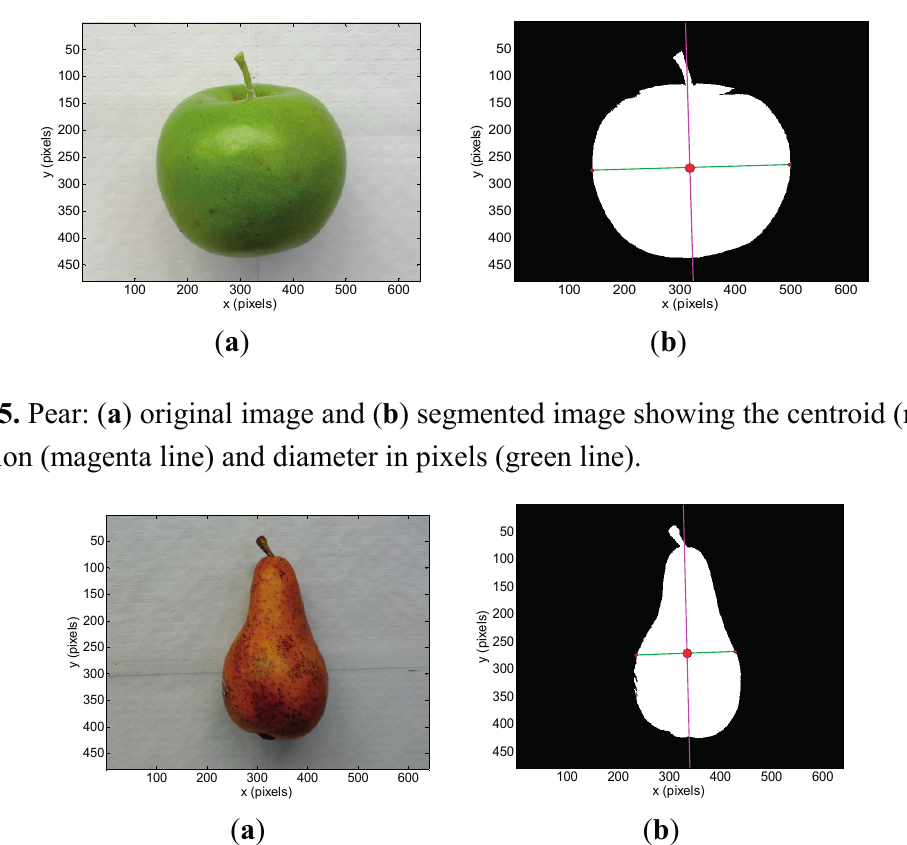
Figure 4. Apple: ( a ) original image and ( b ) segmented image showing the centroid (red dot), inclination (magenta line) and diameter in pixels (green line).